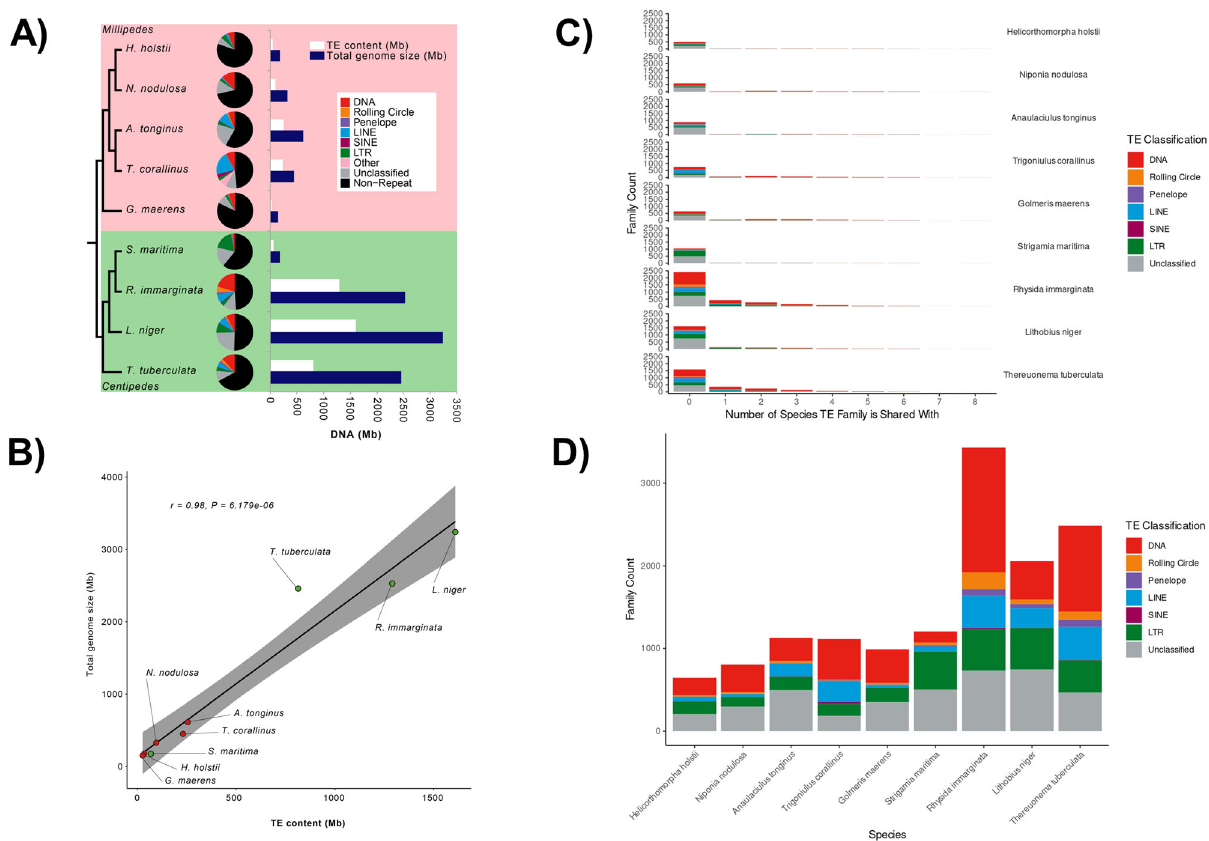
Fig. 2 Transposable elements (TEs) analyses in myriapods. A Summary of TE content in each myriapod genome. B Linear model predicting genome size based on TE content, with the grey area indicating the 95% con fi dence interval for predictions using the model. C Bar chart showing TE families that are shared among sampled myriapods. D Bar chart showing the diversity of TE families in each myriapod